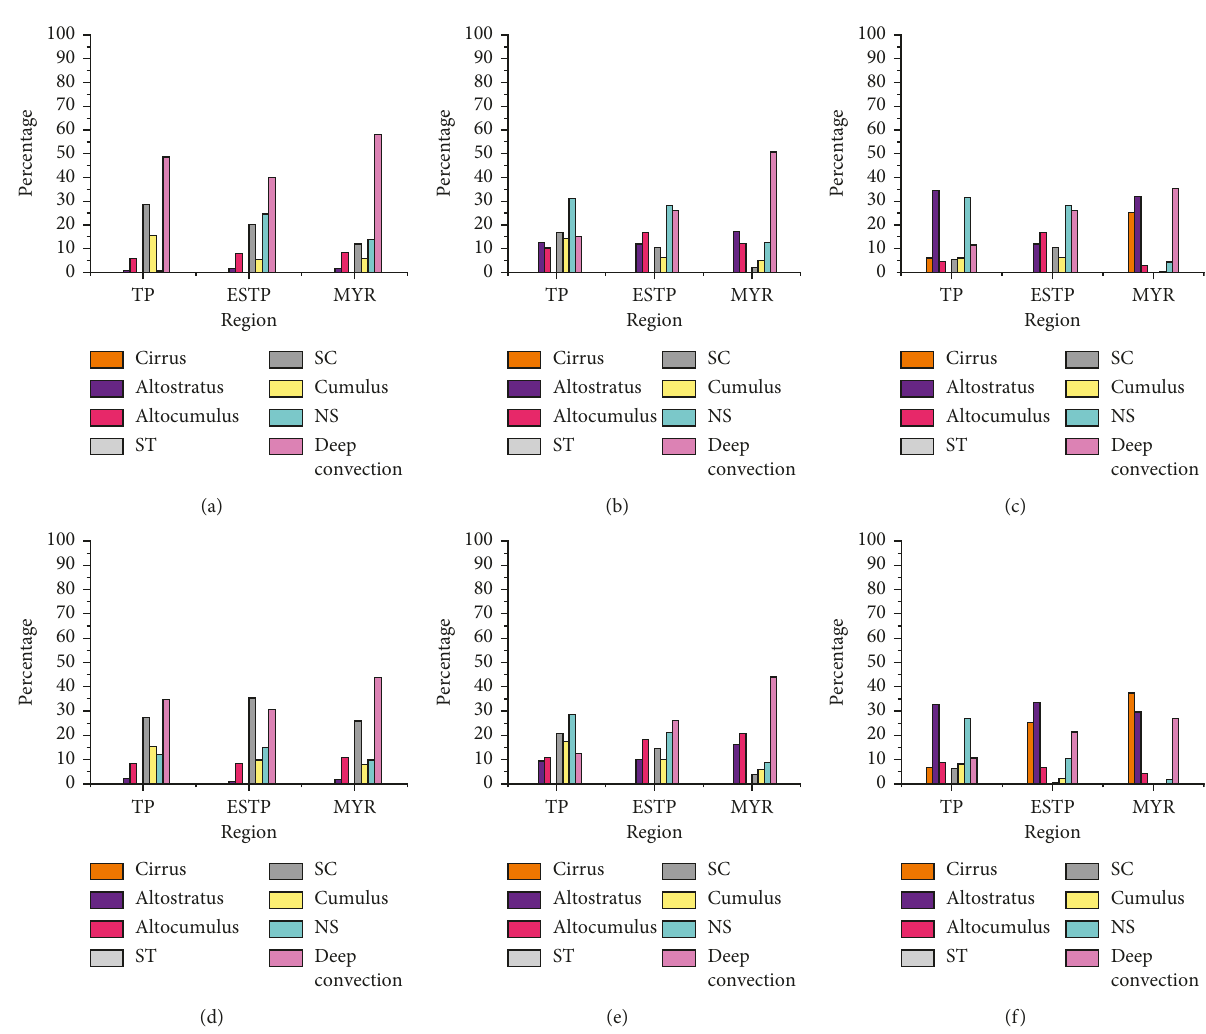
Figure 5: The statistical results of the clouds classification at different altitude levels over each key region. TPV clouds in the (a) lower level (1–5km), (b) middle level (5–10km), and (c) higher level (10–15km).Climatological clouds in the (d) lower level, (e) middle level, and (f) higher level ( X -axis represents different key regions; and Y -axis represents percentage of frequency (unit: